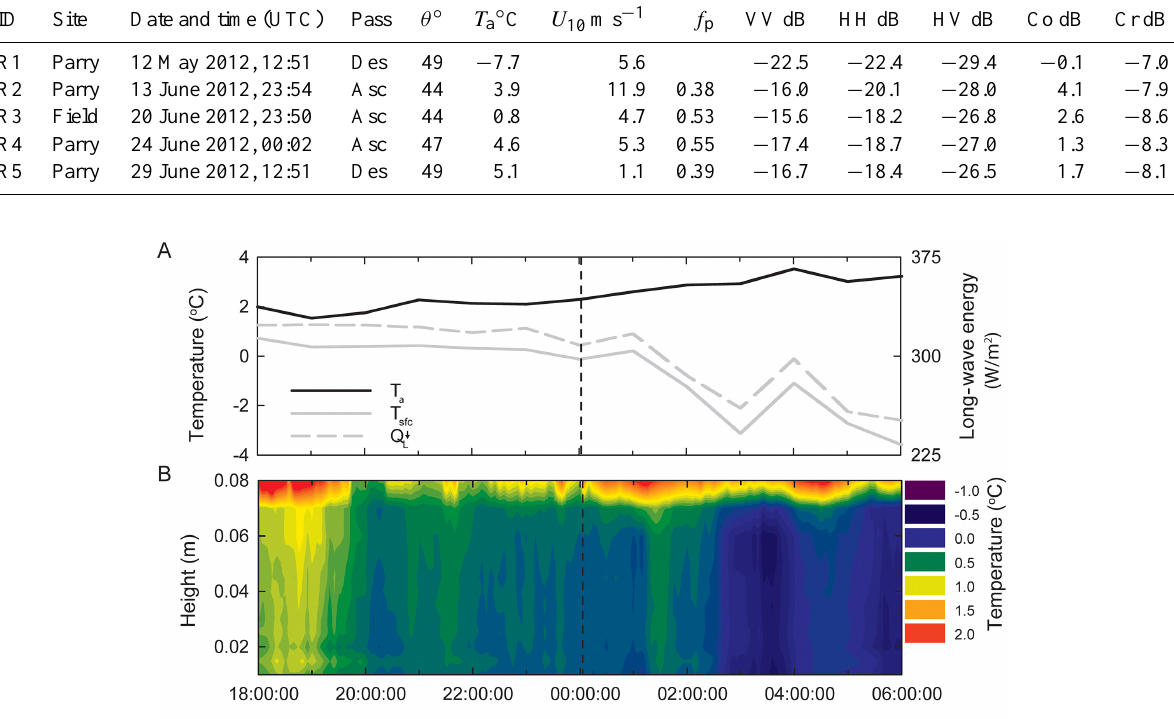
↓ ) . (b) Temperature profile of a melt pond. The L